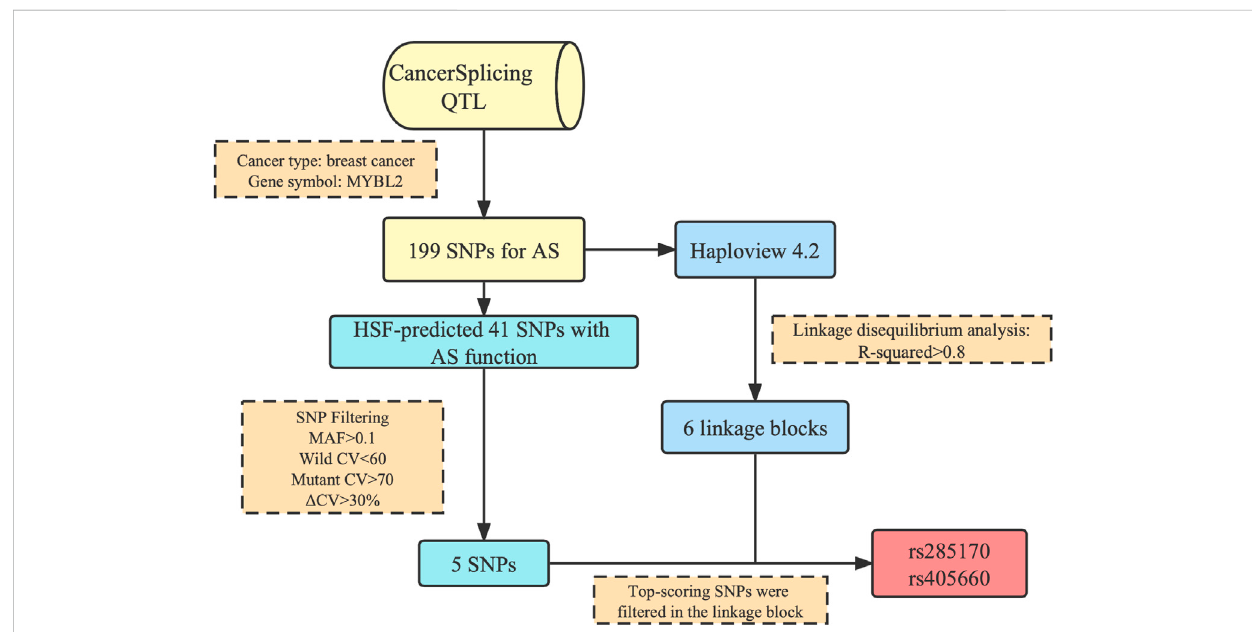
FIGURE 1 Flowchart of MYBL2 alternative splicing-related SNP screening. 199 MYBL2 AS-related genetic variants were acquired at CancerSplicingQTL. Five SNPswithpotentialfunctionsinalternativesplicingwerefurtherscreenedoutinHSF.SixlinkageblocksweresimultaneouslyobtainedbyHaploview.Two SNPs, rs285170 and rs405660, were fi nally included in the follow-up